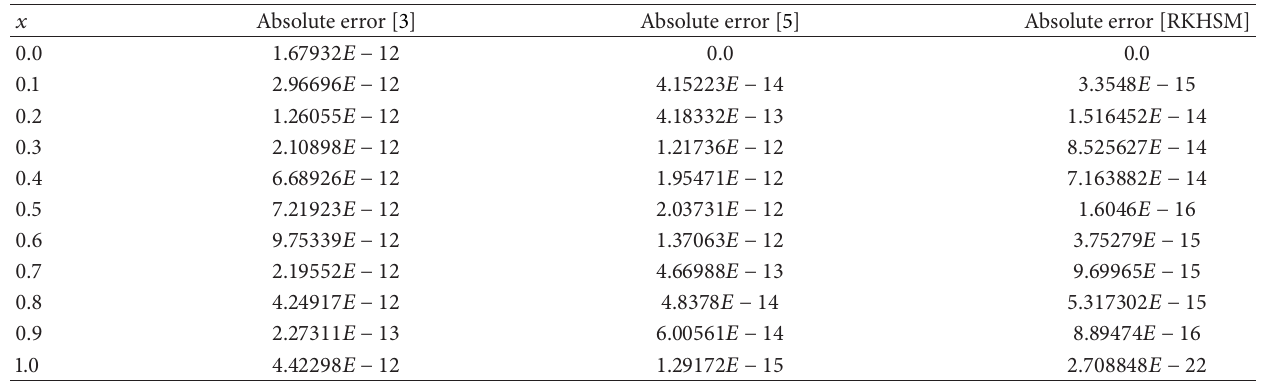
Table 6: Comparison of absolute error of ADM, HAM, and